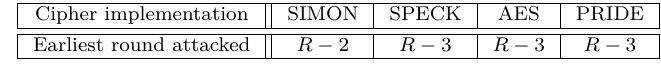
Table 6: Results of running Algorithm 4 on exploitable nodes found in Section 5. R denotes the number of rounds for each cipher.